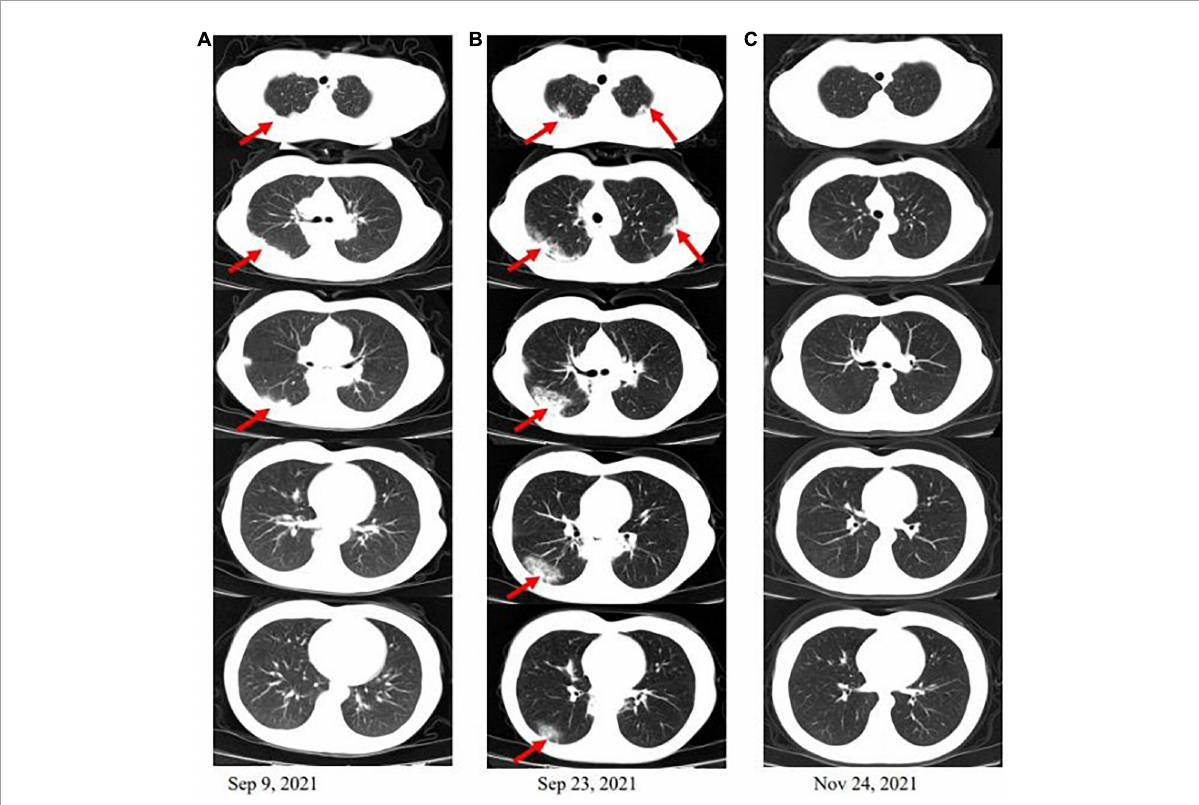
FIGURE1 Computed tomography (CT) scan of the chest. (A) There are lesions of infiltrates under the pleura of the right lung when the patient is admitted. (B) After 2 weeks of antibiotic therapy, countercheck thoracic CT shows that pulmonary infiltrates are not significantly absorbed and appear to spread to the left lung and lower in the right. (C) The infiltrations under the pleura in both lungs were basically absorbed after a mouth of corticosteroid